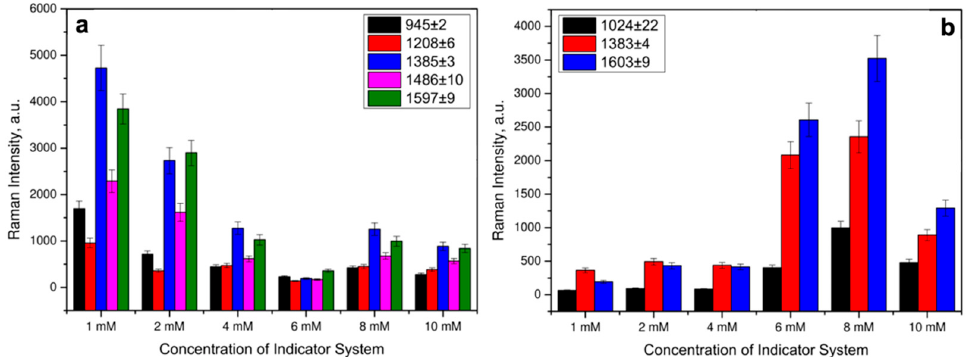
Figure 4. Raman intensities of characteristic DA bands in the SERS spectra at different concentrations of Cu(II) and ligands for: ( a ) L 3 and ( b ) L 2 . Error bars are shown for n = 20, p = 0.95.